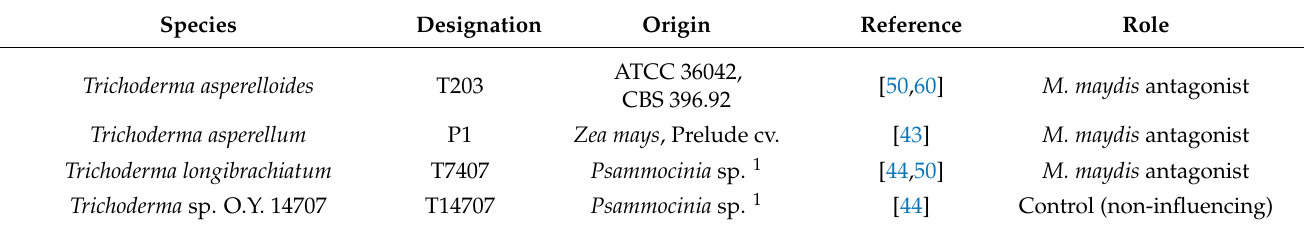
Table 1. List of Trichoderma spp. isolates used in this study.